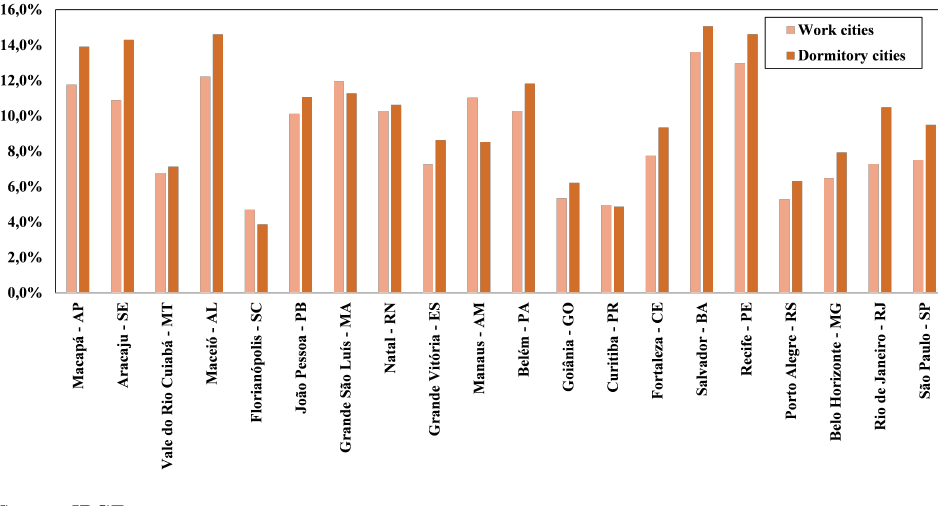
Figure 4: Average unemployment rate for people who live in work or dormitory cities inside each metropolitan area, (ordered by the size of working population),